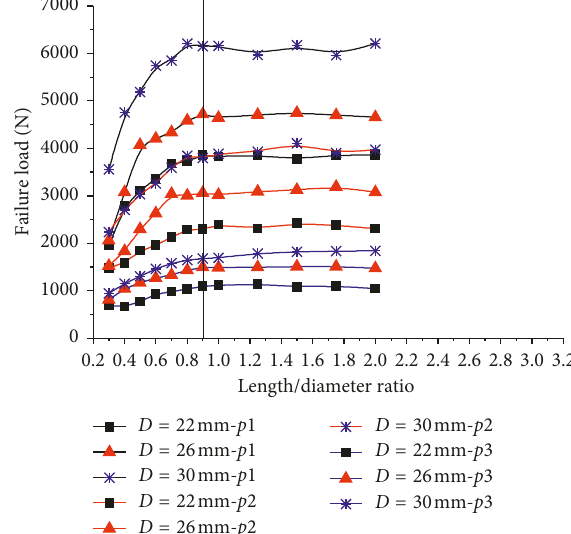
Figure 9: The results of the failure load with the length/diameter ratio.